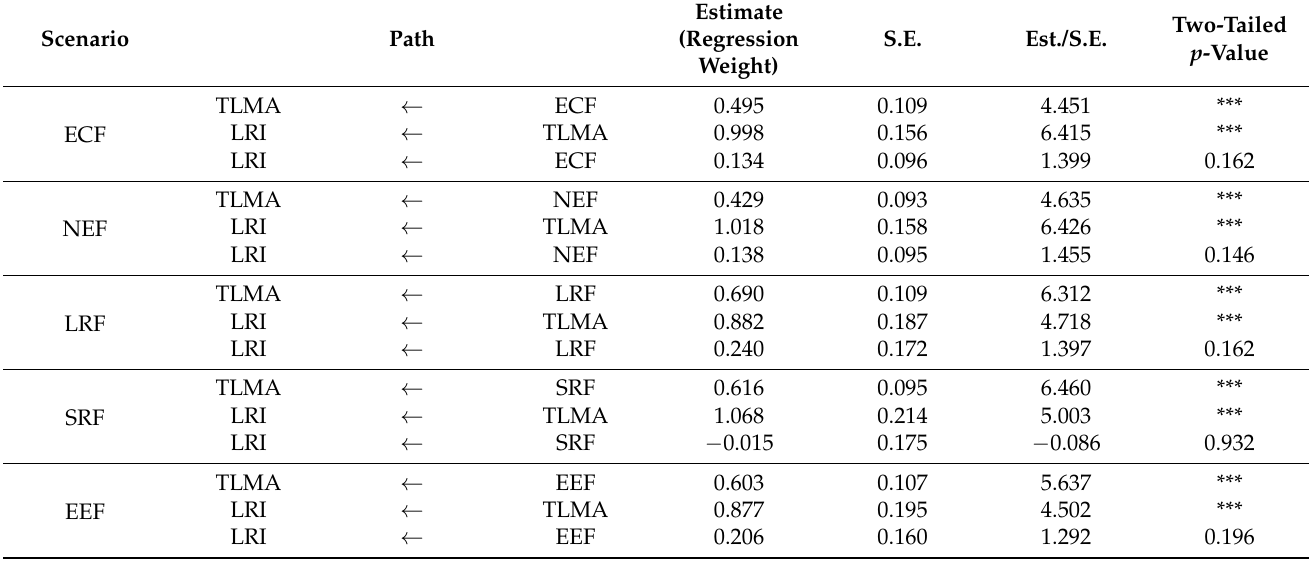
Table 4. Unstandardized path coefficients and significance of the